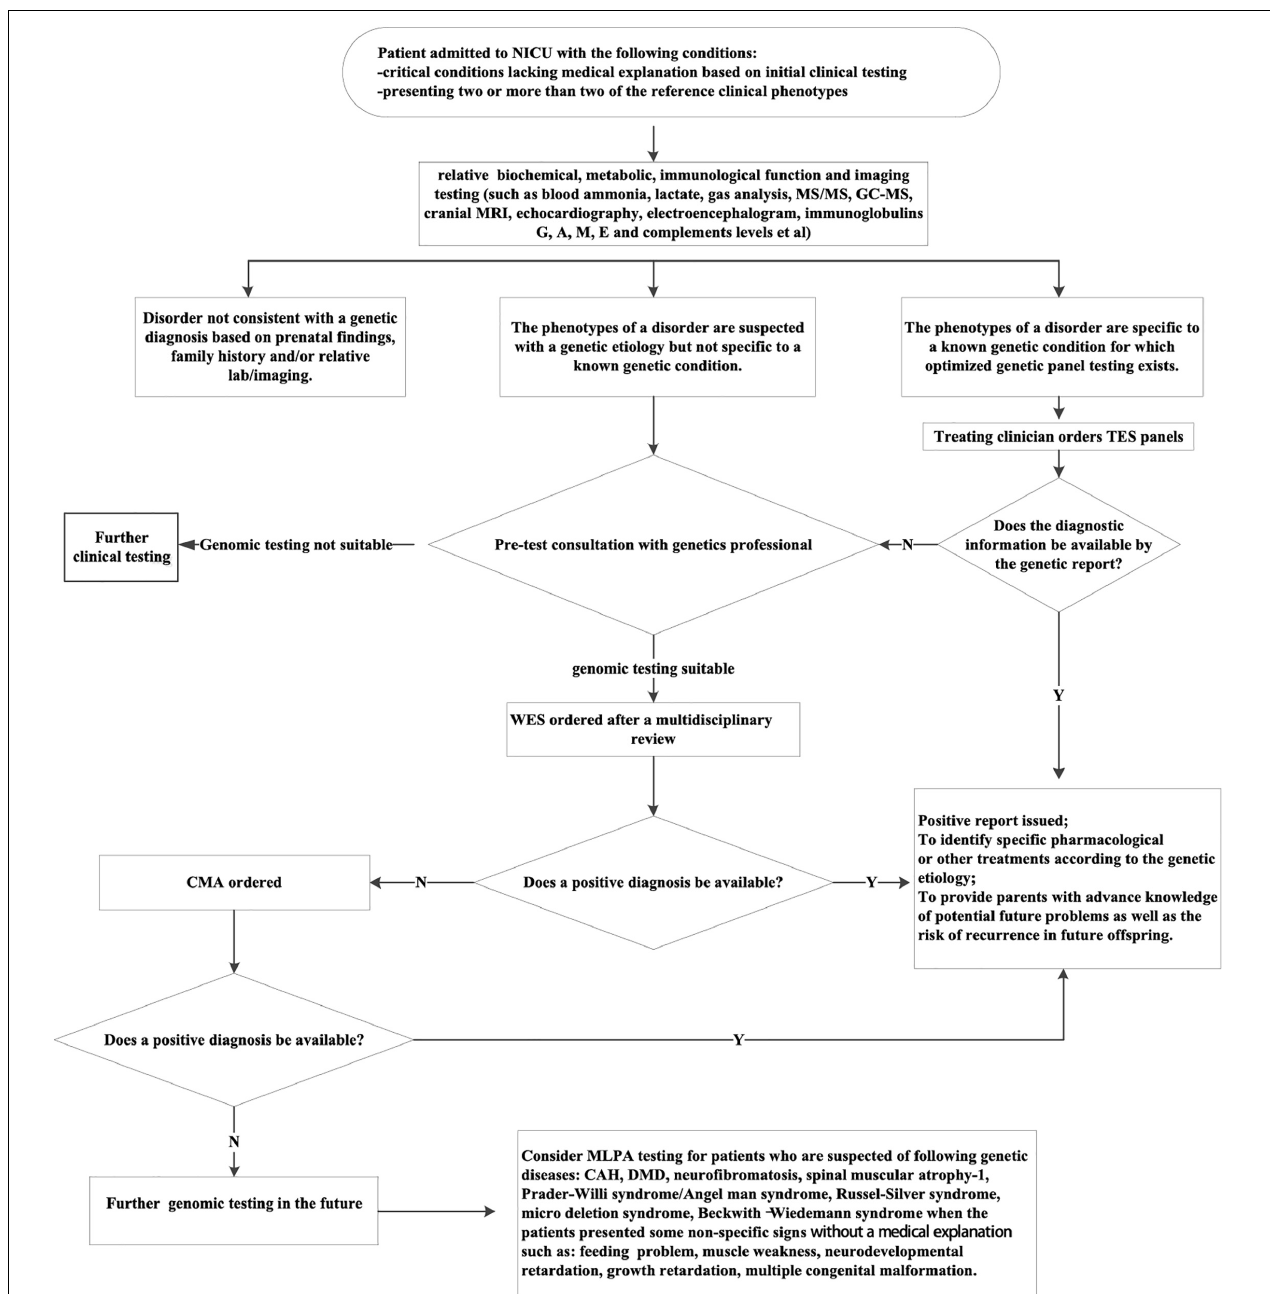
FIGURE 4 | The proposed molecular diagnostic procedure to identify the genetic etiology of critically ill patients from NICUs. CAH, congenital adrenal cortical hyperplasia; CMA, chromosomal microarray analysis; DMD, Duchenne muscular dystrophy; MLPA, multiplex ligation-dependent probe amplification; TES, targeted exome sequencing; WES, whole-exome sequencing. The reference clinical phenotypes includes complex metabolic phenotypes (e.g., persistent hypoglycemia, hyperkalemia, hyponatremia, metabolic acidosis, lactic acidosis, and hyperammonemia); unexplained neurological signs (e.g., seizures and hypotonia); unexplained respiratory failure; unexplained abnormalities of the cardiovascular system (e.g., cardiomyopathy and arrhythmia); skin lesions of unknown origin(e.g., ichthyosis and blister); unexplained thrombocytopenia or anemia; congenital malformations that are not consistent with any known syndrome; unexplained abnormalities of the immune system(e.g., recurrent infections, protracted diarrhea, leukocytosis, leukopenia, and abnormal immunoglobulin level); unexplained cholestasis.